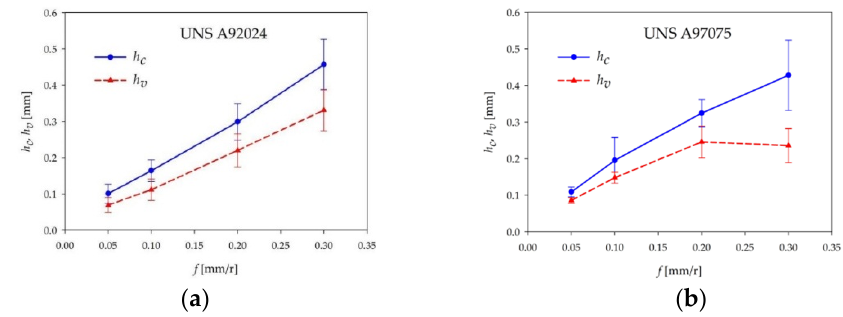
Figure 8. Height of peaks ( h c ) and valleys ( h v ) as a function of feed for ( a ) UNS A92024 and ( b ) UNS A97075.